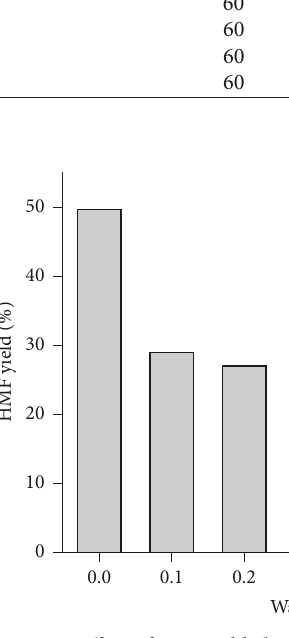
50mg, S-AlMo cata- (cid:29)